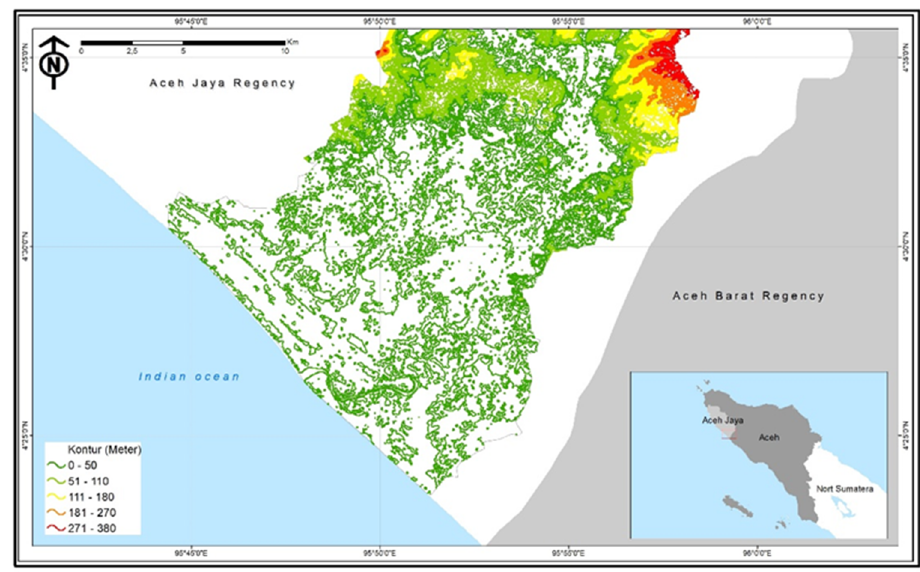
Figure 4. Geomorphological map of the Teunom watershed (combination of field survey results and Figure 3. Geomorphological map of the Teunom watershed(combination of field survey results and geospatial data). geospatial data).